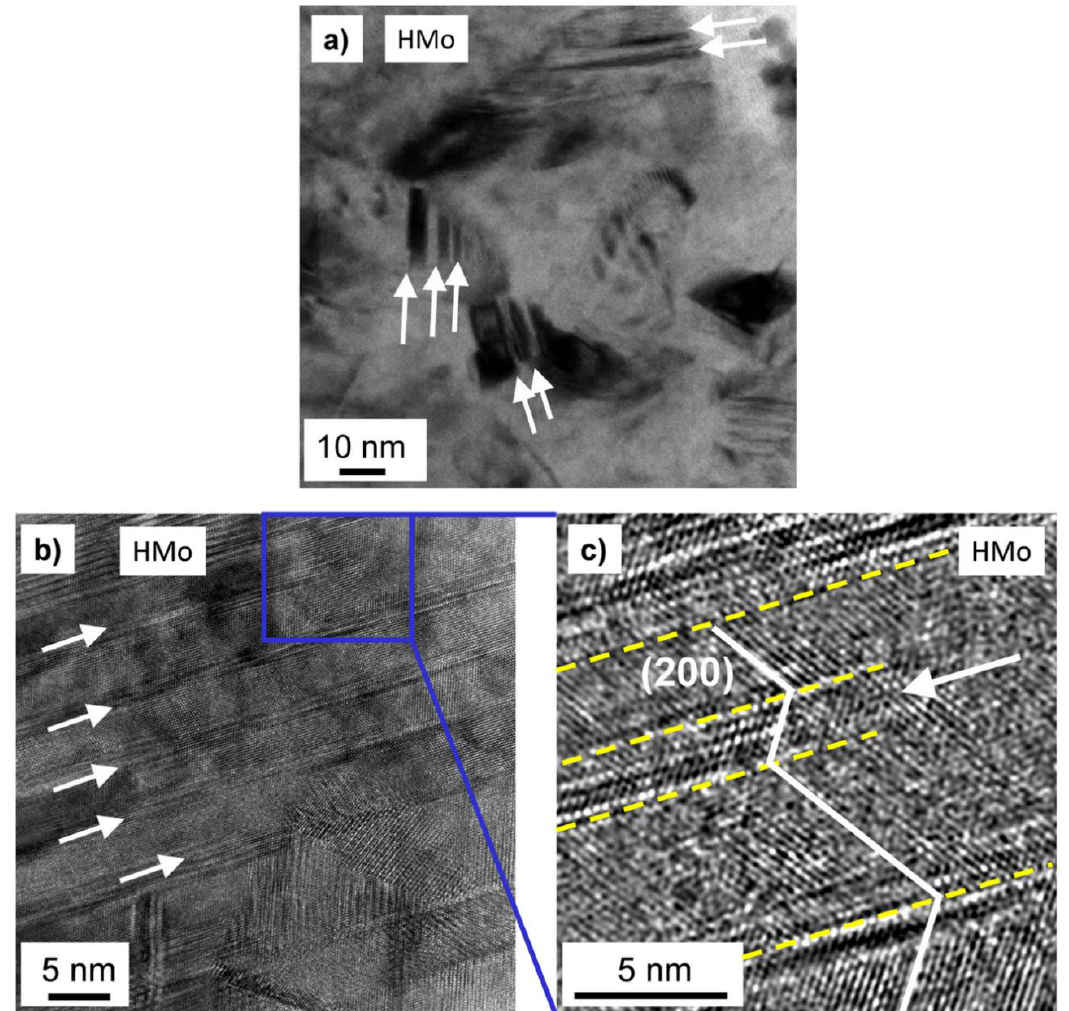
Figure 2. Bright-field TEM micrograph ( a ) and high-resolution TEM (HRTEM) image ( b ) taken on sample HMo. The white arrows indicate some twin faults. ( c ) shows a magnified and Fourier-filtered part of ( b ) (indicated by the blue frame). The dashed yellow lines mark twin faults. The white arrow in ( c ) indicates a twin lamella ending in the grain interior.